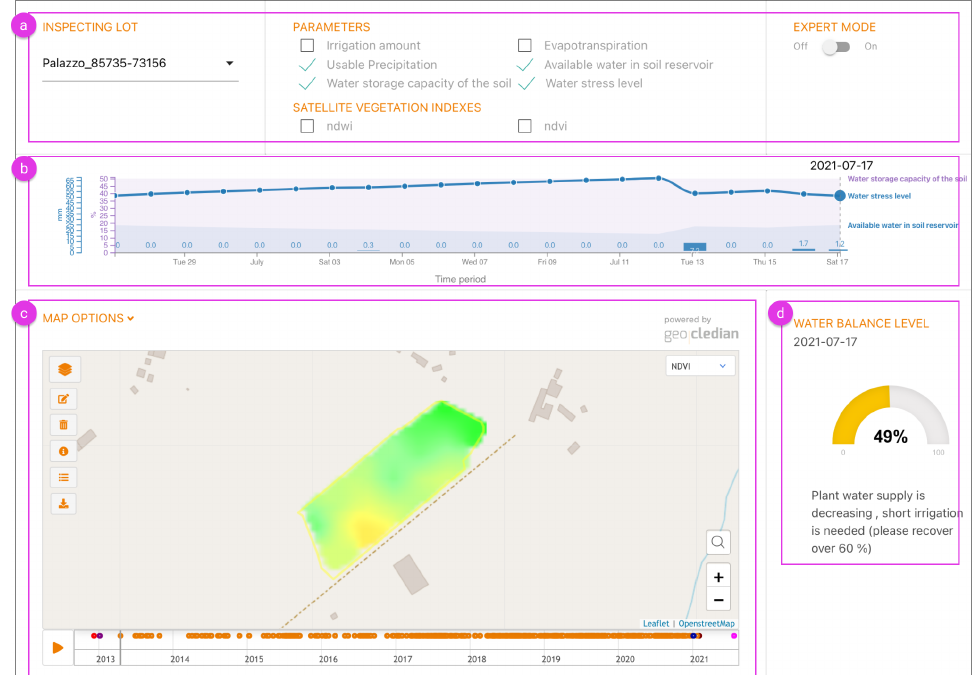
Figure 8. Interface for the analysis of water stress and irrigation requirements: ( a ) toolbar; ( b ) chart visualising the parameters selected in the toolbar; ( c ) map widget visualising satellite data for the selected lot; ( d ) gauge visualising the water balance level with a text-based irrigation